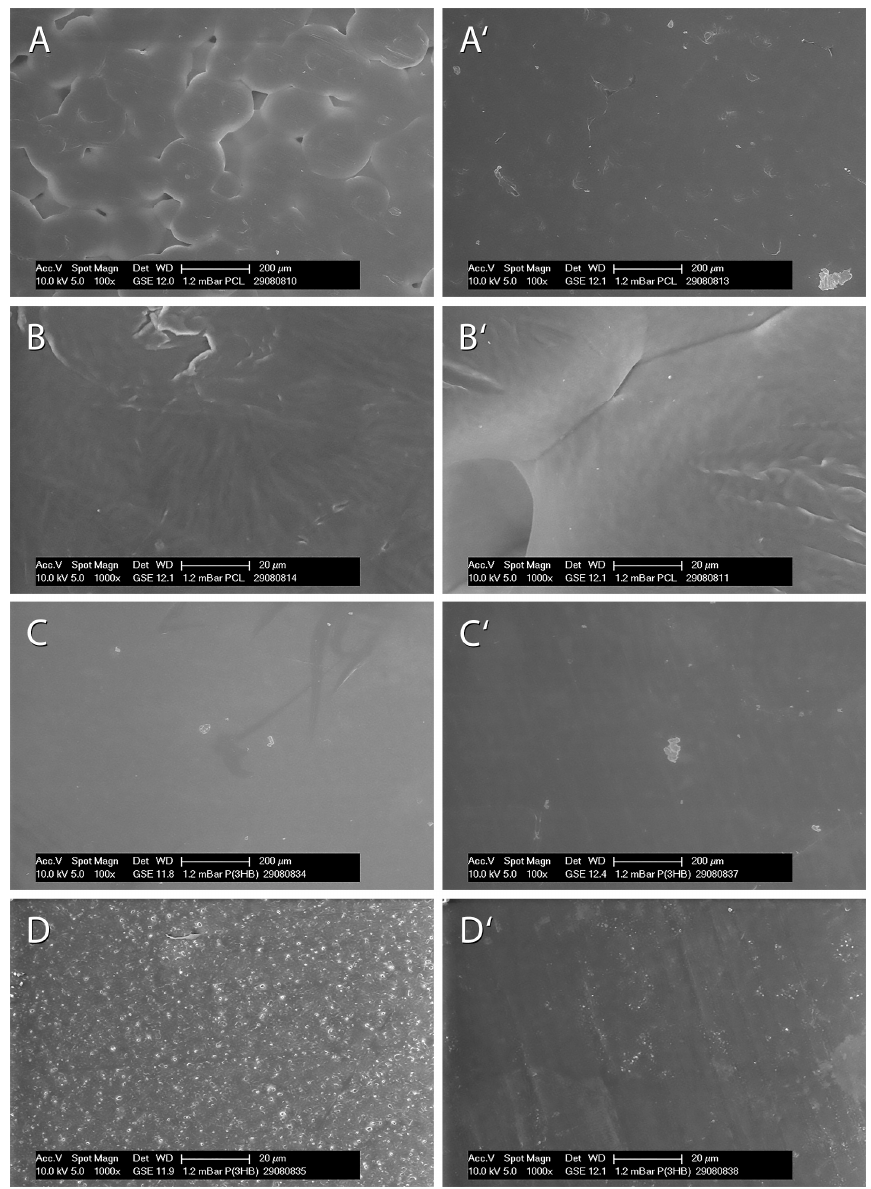
Figure 7. Representative ESEM micrographs of PCL (( A , B ) first side and ( A ’, B ’) second side) and P(3HB) (( C , C ’) fist side and ( D , D ’) second side) foils in overview (( A , A ’) and ( C , C ’); 100-fold magnification, scale bar: 200 µm) and in detail (( B , B ’) and ( D , D ’); 1000-fold magnification, scale bar: 20 µm).